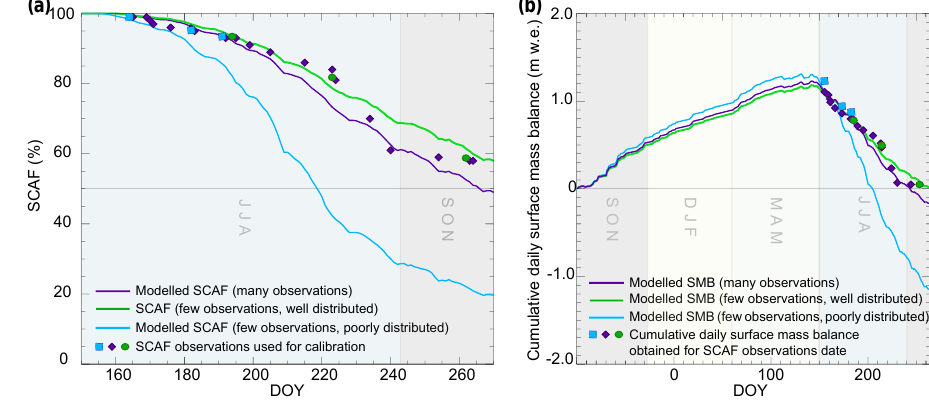
Figure 5. Examples of the (a) daily SCAF and (b) cumulative daily SMB obtained with different sets of image frequency and distribution for Abramov in 2016. TSL observation dates used to calibrate the model are indicated with symbols. The modelled daily SCAF and cumulative daily SMB and their corresponding TSL observations are shown with the same colour. Three images were used at the beginning of the ablation season (blue), three images were well distributed throughout the ablation season (green) or all available images (purple) were used.